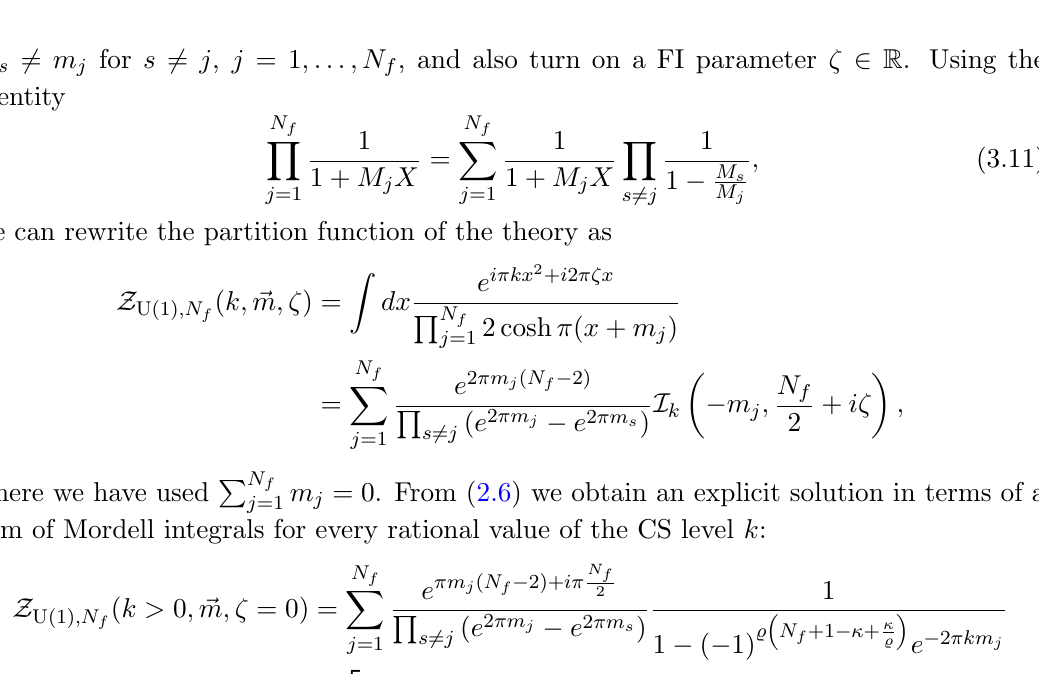
Figure 7 . Abelian A 1 quiver with N f fundamental